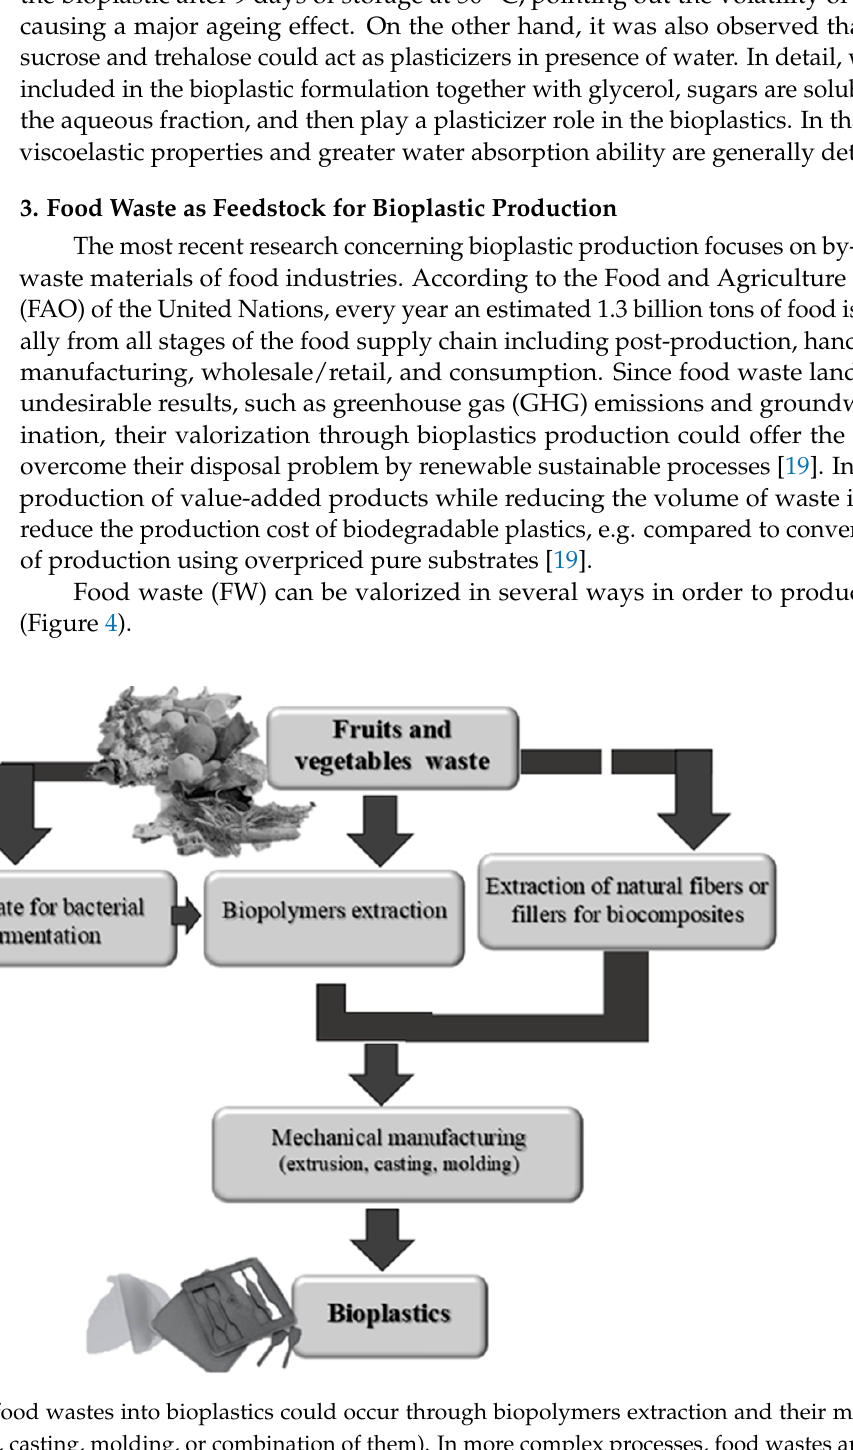
Figure 3. Effects of the plasticizers’ addition on mechanical and physical properties of bioplastic materials.